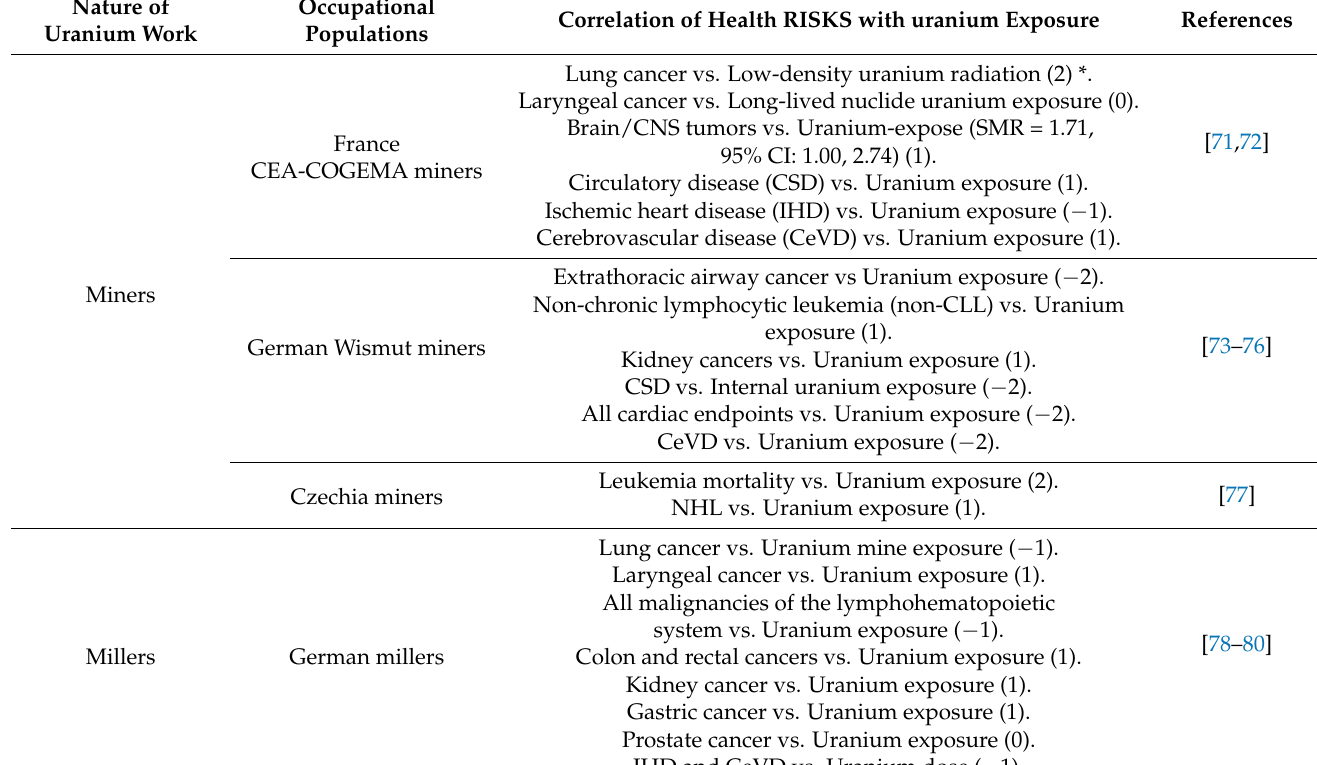
Table 3. Epidemiologic studies of health risks exposure to particulate